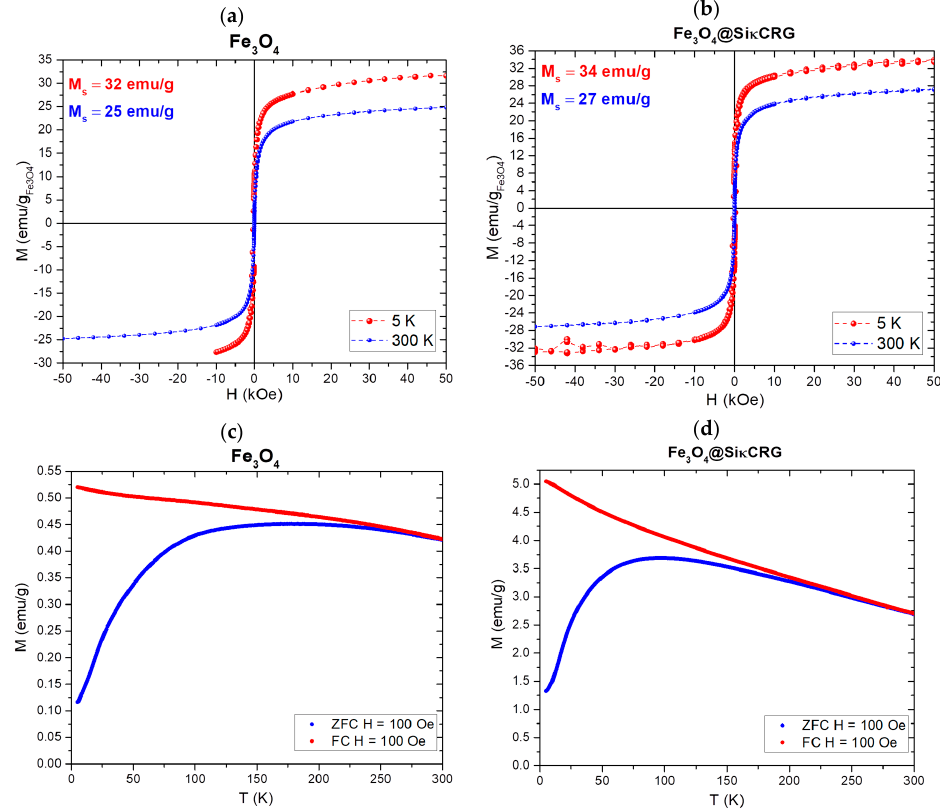
Figure 3. Field dependent magnetization curves (normalized for iron oxide content) of Fe 3 O 4 nanoparticles ( a ) and Fe 3 O 4 @Si κ CRG nanoparticles ( b ). Temperature dependent magnetization curves of Fe 3 O 4 nanoparticles ( c ) and Fe 3 O 4 @Si ĸ CRG nanoparticles ( d ). Table 2. Magnetic parameters for Fe 3 O 4 and Fe 3 O 4 @Si κ CRG particles, at 300 K. Material